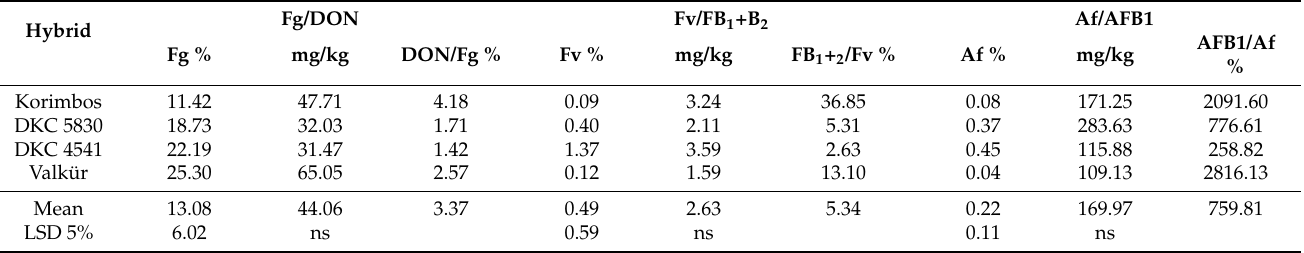
Table 7. Resistance and toxin relationships in commercial maize hybrid controls. Ear rot amount, toxin contamination, and the rate of toxin production for 1% ear rot severity (Szeged, 2017–2020). Ranking: F. graminearum kernel